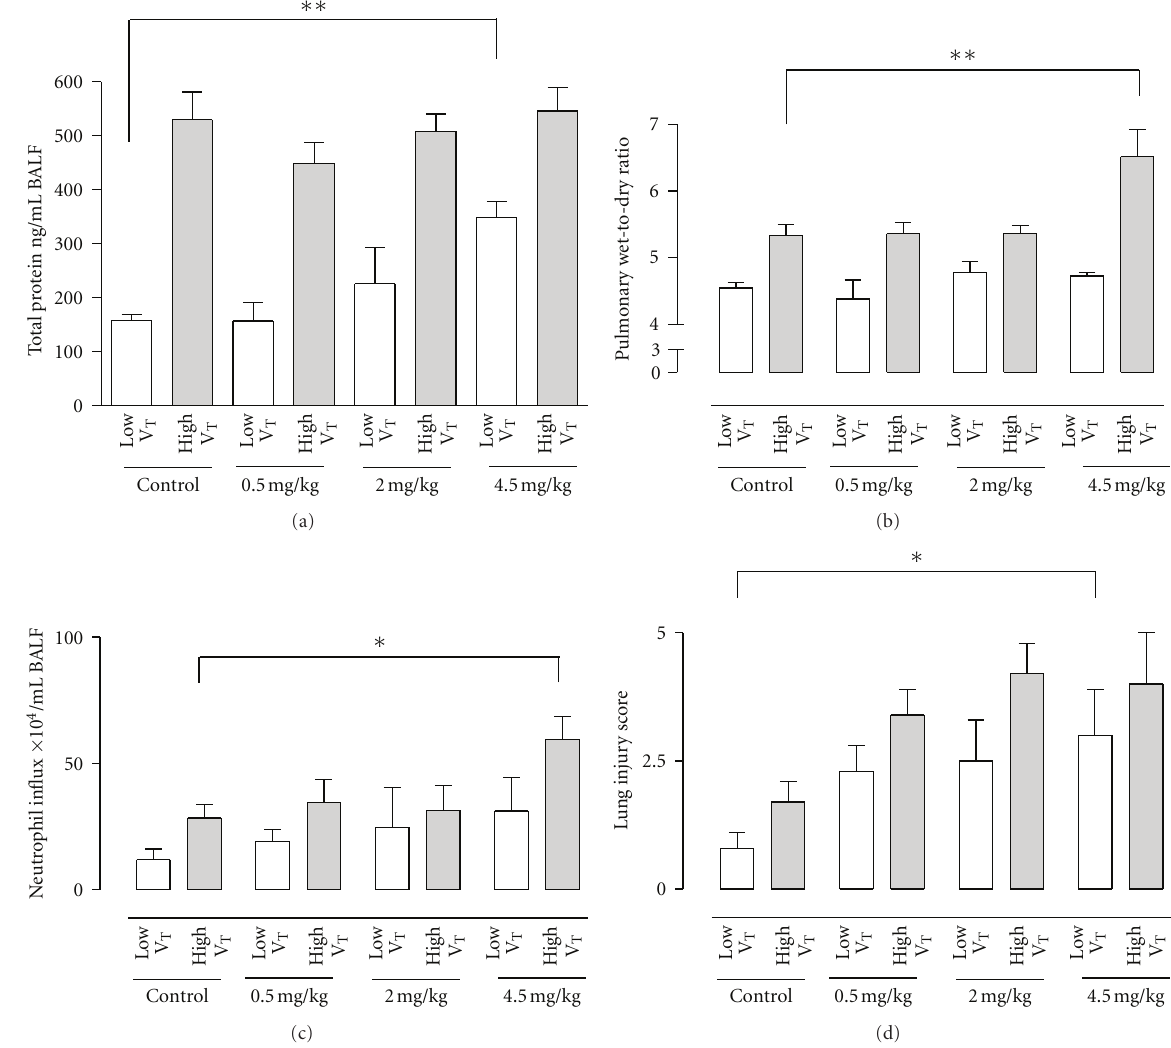
Figure 1: (a) Total protein in the bronchoalveolar lavage fluid (BALF) ( n = 12 per group), (b) wet-to-dry ratio of the lungs ( n = 6 per group), (c) neutrophil influx in bronchoalveolar lavage fluid ( n = 12 per group), and (d) histopathological examination of lung tissue ( n = 6 per group). Low V T = mice ventilated with a tidal volume of 7.5 mL/kg; high V T = mice ventilated with a tidal volume of 15mL/kg. Dose of MHC-I antibodies infused 0.5, 2.0, and 4.5mg/kg. Controls received vehicle. BALF = bronchoalveolar lavage fluid. ∗ P < 0 . 05, ∗∗ P < 0 .